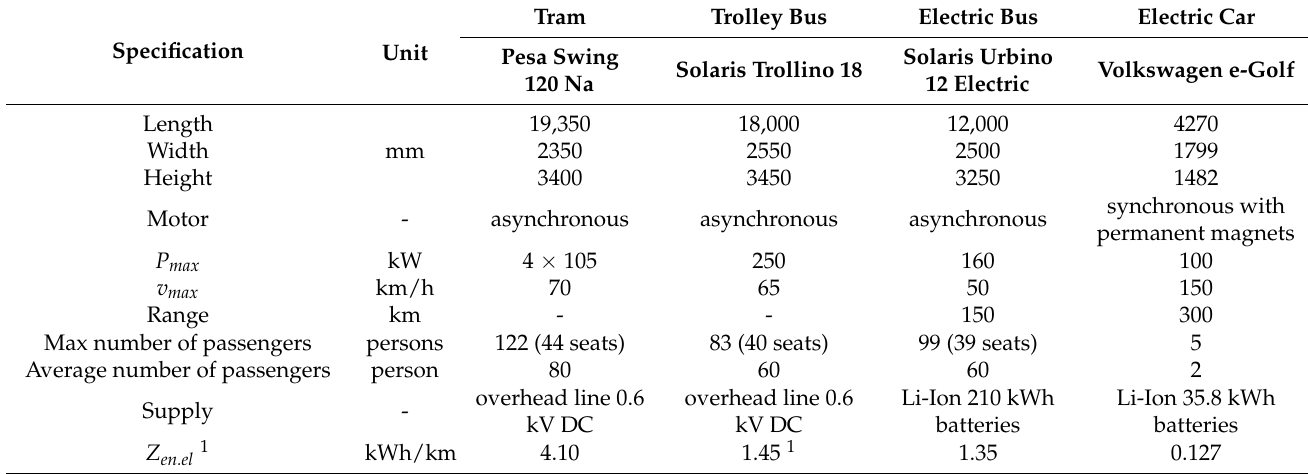
Table 4. Examples of electric vehicles with their specification